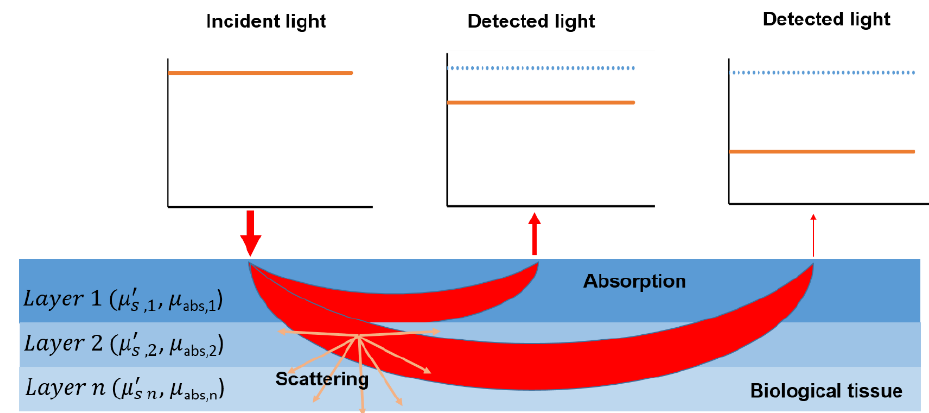
Figure 5. The source emits light at the same intensity and the changes in the intensity are measured then by the detector. The figure illustrates two detected signals successively along with the possible photon paths “banana shape” in different layers with various absorption coefficient and reduced scattering coefficient.